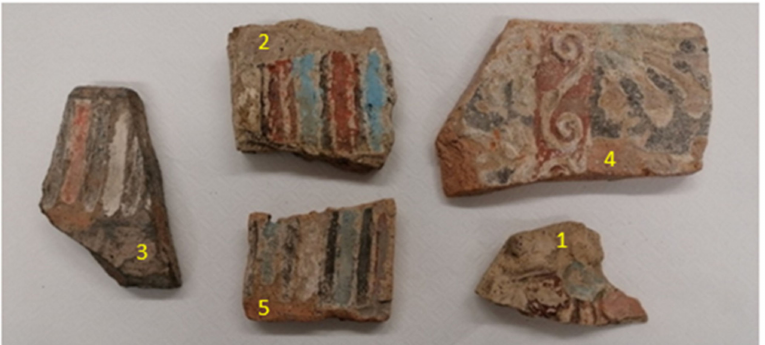
Figure 2. The five samples analyzed by µ -Raman and pXRF. Labels 1–5 refer to the studied